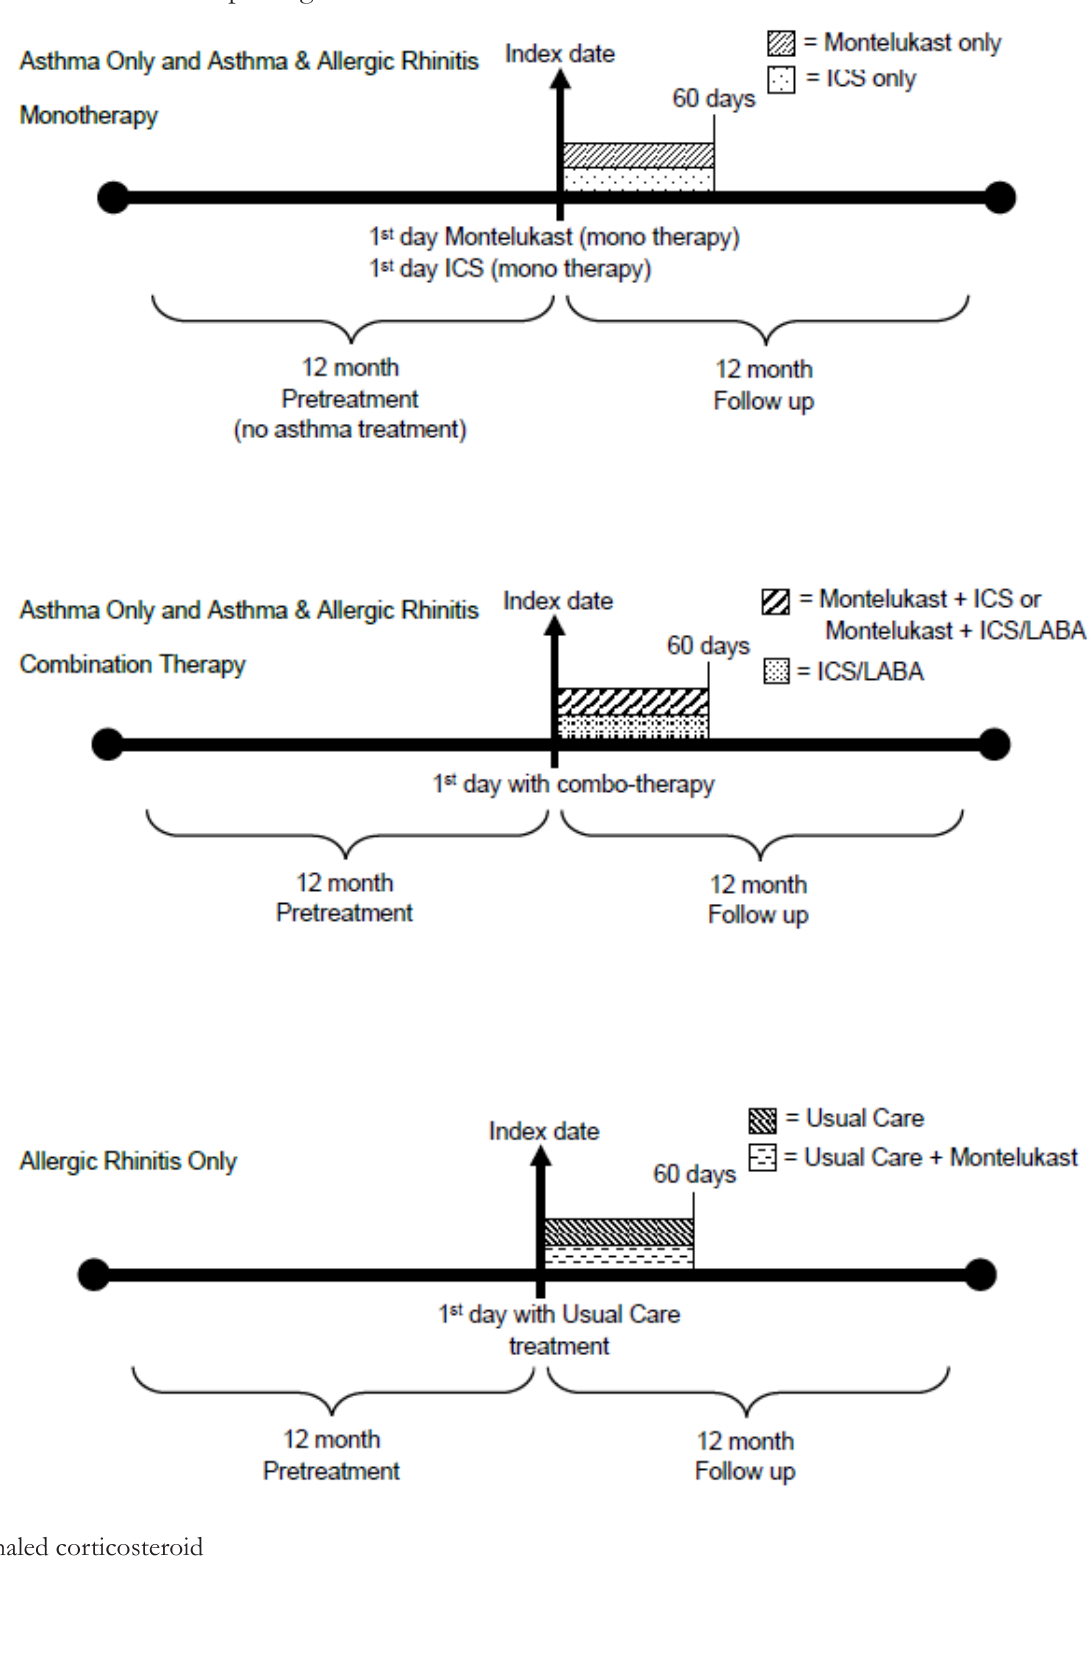
Figure 1. Treatment Group Assignment